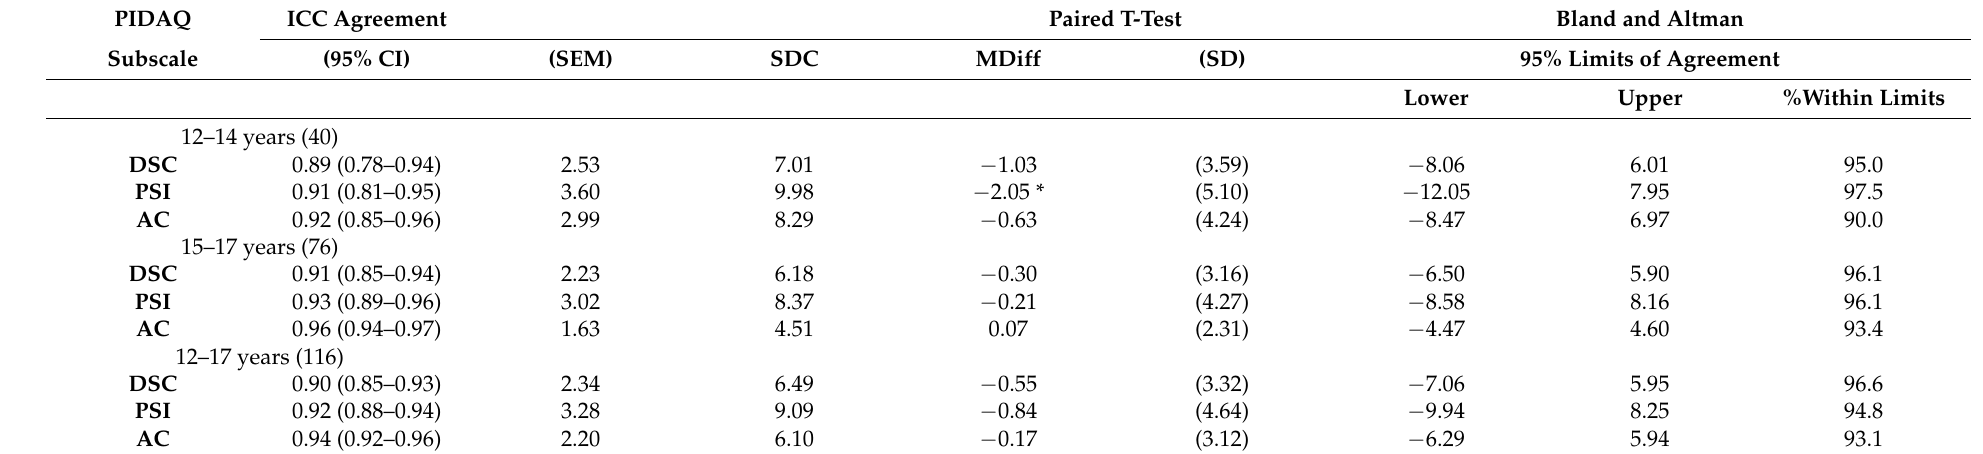
Table 4. The reproducibility tests of the PIDAQ(A) (test–retest